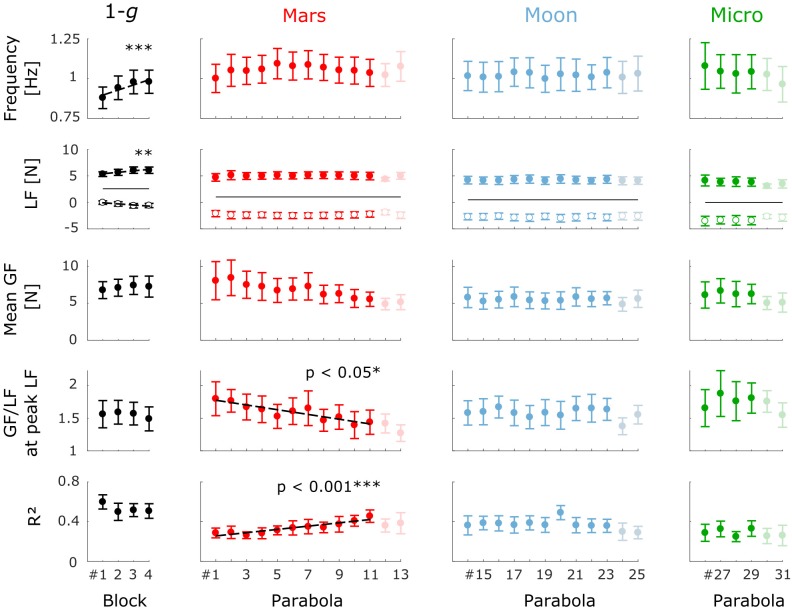
Mean (±standard error [N = 8]) kinematic and dynamic variable values by block number within each gravity condition. From top to bottom: movement frequency, LF minimum (open circles), and LF maximum (filled circles), mean GF, GF/LF ratio at the time of peak LF, and R2 coefficient. The solid black lines in the LF plots represent the weight of the manipulandum. Blocks plotted in the 1-g condition are the four first blocks performed on board the aircraft. The regression lines estimated by the mixed-effects models are plotted (dashed lines) where the effect of block number is significant (∗p < 0.05; ∗∗p < 0.01; ∗∗∗p < 0.001). The last two parabolas of each session (faint dots) were not included in the analysis (see the section “Materials and Methods”).